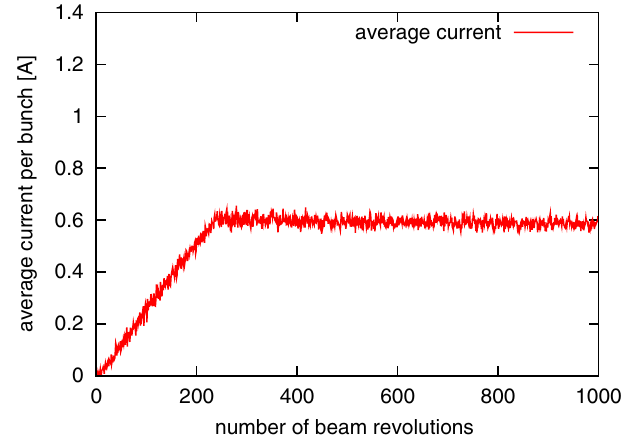
FIG. 3. (Color) Typical average current per bunch up to 1000th turn. The beam from the linac is injected for 234 turns. This is equivalent to 500 (cid:2) s at the revolution frequency of 469 kHz during the injection period.